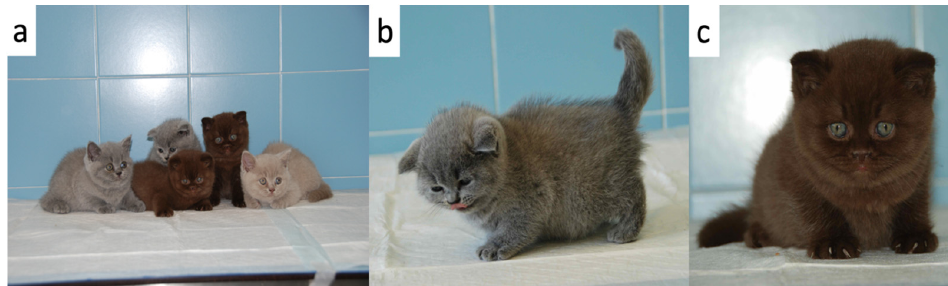
Figure 1. Congenital hypothyroid kittens and healthy siblings ( a ) The 3 kittens with growth failure (in the middle) together with their healthy littermates (left and right) at the time of presentation ( b ) One of the 3 kittens (kitten F1) with a short block ‐ like body and a fluffy hair coat ( c ) One of the 3 kittens (kitten M1) with a short neck, blue eyes, and ventral curling of the pinnae.